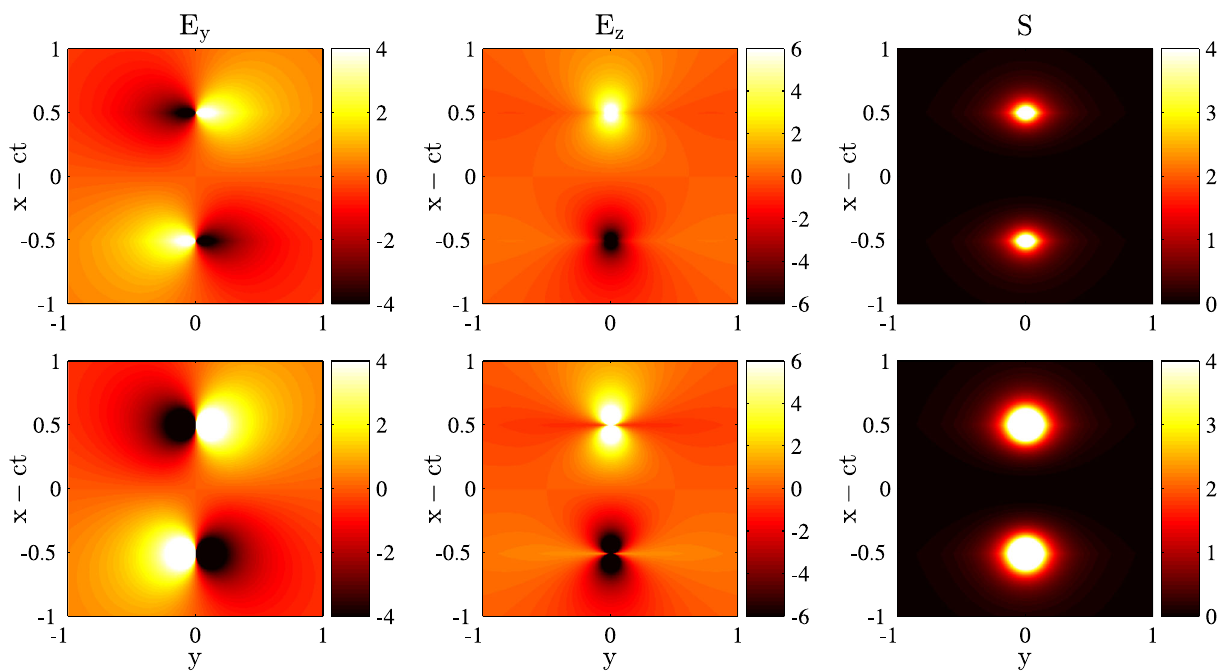
FIG. 6. The field components and the energy flow density of the surface wave from the rectangular bunch with q ¼ 1 esu. Gaussian units are used. The bunch length is 2 σ ¼ 1 cm for all pictures; ~ κ ¼ 0 . 0148 cm for the first row, and ~ κ ¼ 0 for the second row; δ ¼ 0 , z ¼ þ 0 , ct > σ , and β ¼ 1 .